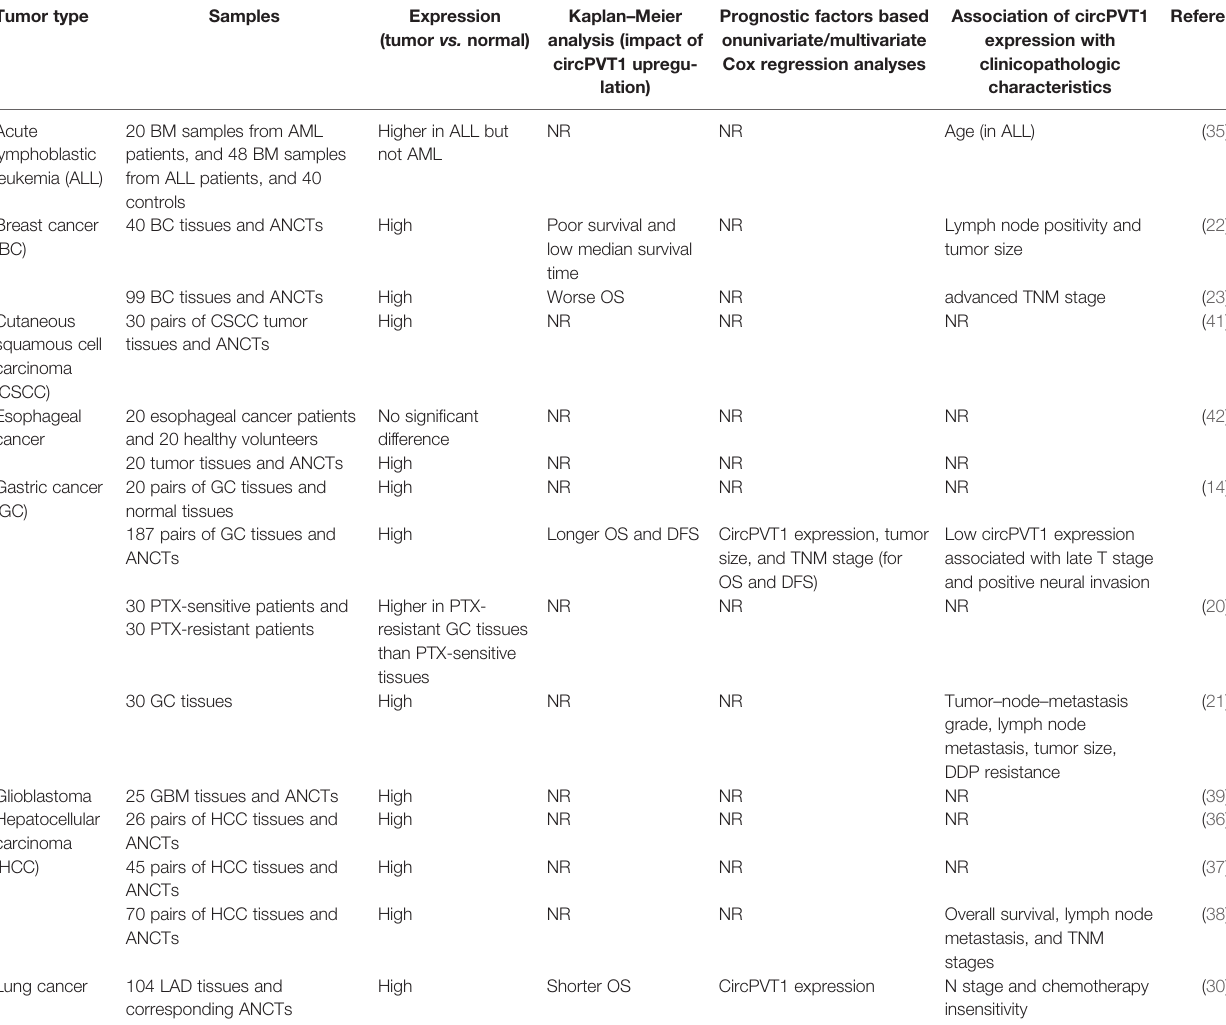
TABLE 3 | Impact of circPVT1 carcinogenesis based on human